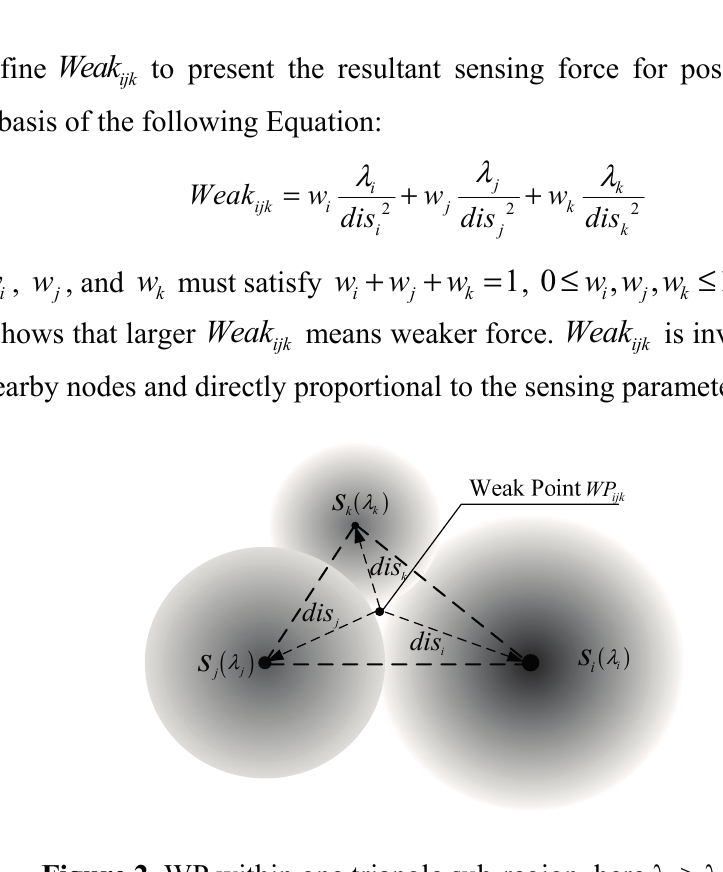
Figure 2. WP within one triangle sub-region, here λ i > λ j > λ k